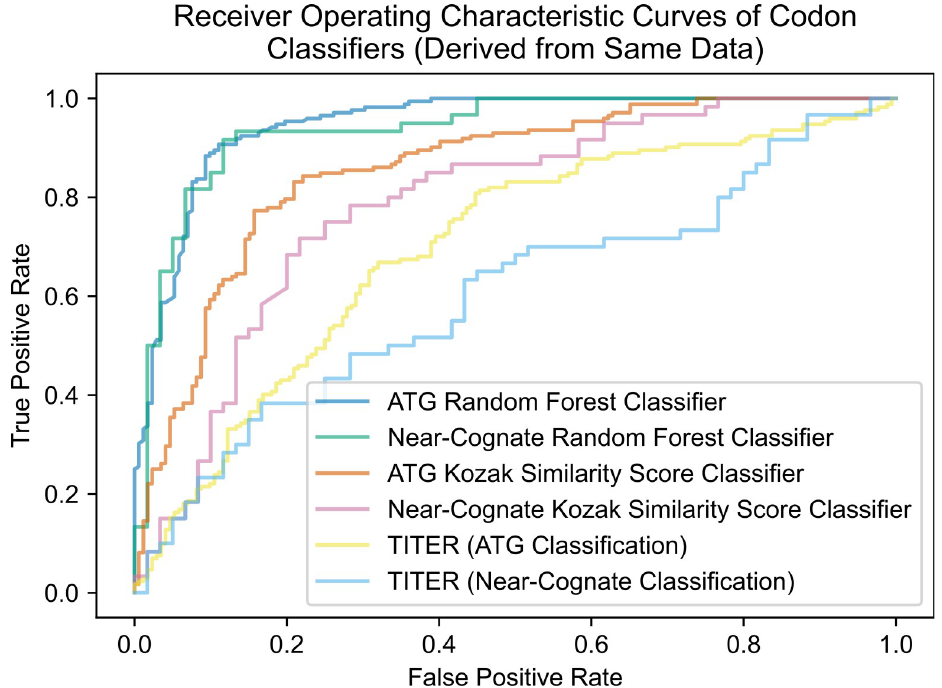
Fig 8. ROC curves of all ATG and near-cognate classifiers derived from same test data. All classifiers were run on the ATG and Near-cognate RFC test datasets, and their ROC curves were superimposed. The AUROC scores of the ATG and near-cognate RFCs are 0.95 and 0.94, respectively. The AUROC scores of the ATG and near-cognate KSS classifiers are 0.86 and 0.79 respectively on these test datasets. TITER’s AUROC scores are 0.62 and 0.60 for ATG and near-cognate codons,